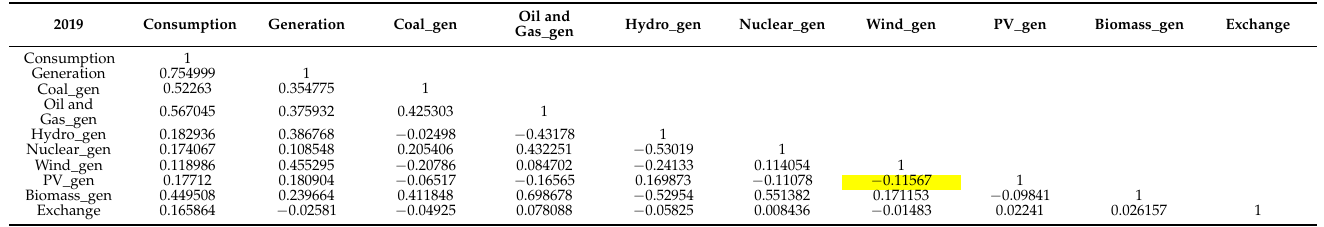
Table 2. Correlation coefficients between consumption and generation sources in 2020.